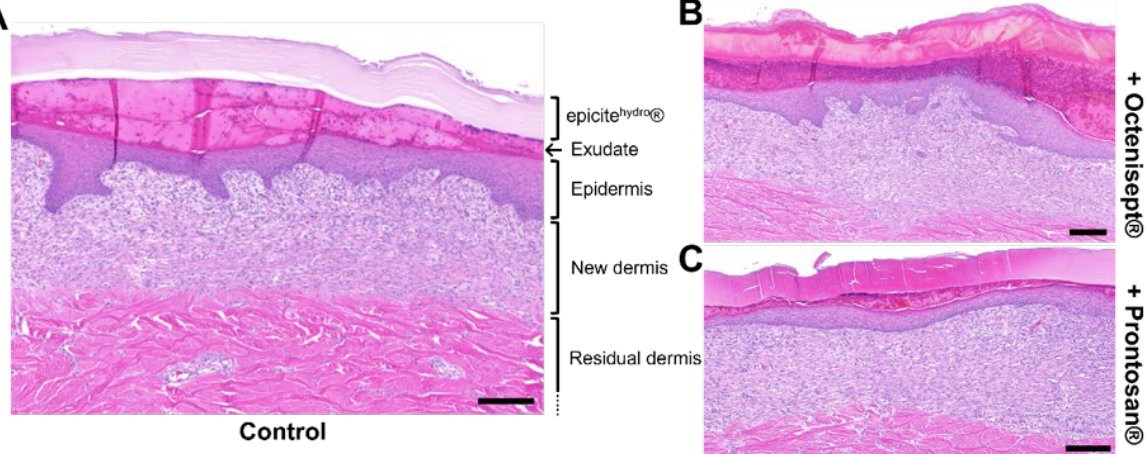
Figure 4. Histological aspects of the regenerated tissue. H&E stainings of representative examples of the regenerated tissue after 7 days of treatment with epicite hydro® (n = 16 wounds) ( A ), epicite hydro® combined with Octenisept ® (n = 24 wounds) ( B ) and combined with Prontosan ® (n = 24 wounds) ( C ). Scale bars representing 200 μm.